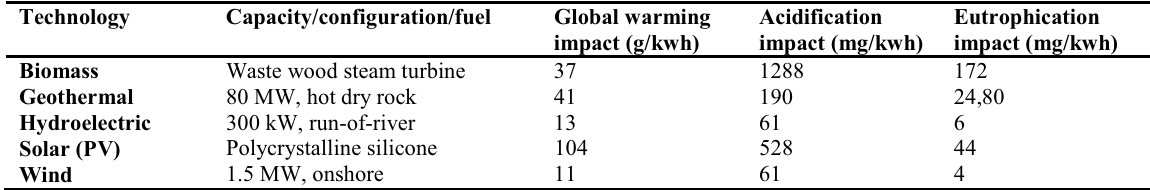
Table 3: Environmental impacts of energy production